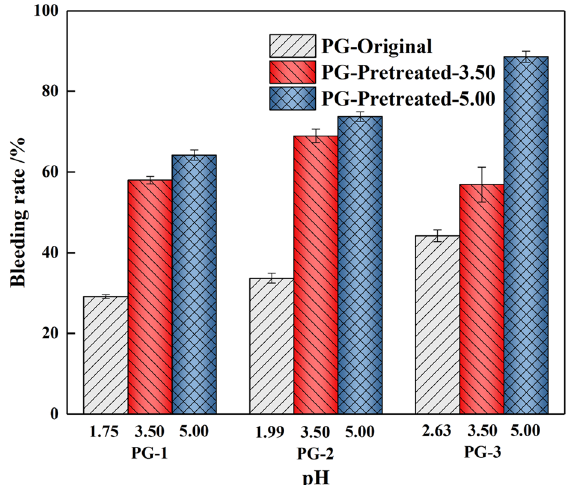
Figure 7. Variation of bleeding rate in backfill slurry.